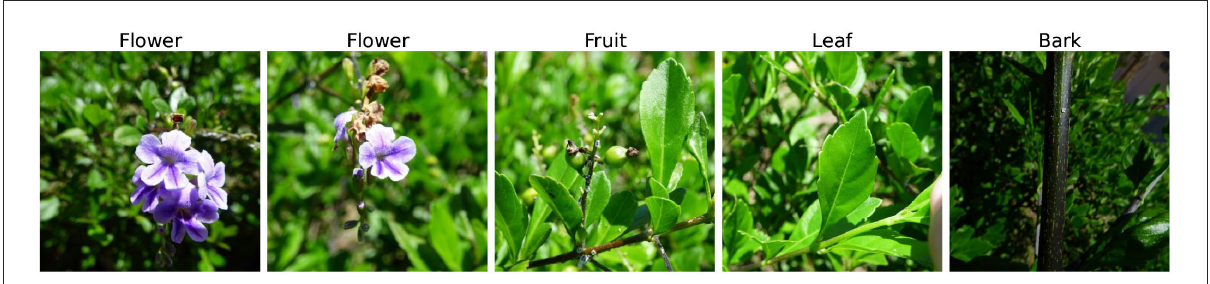
FIGURE2 A PlantCLEF observation—images of different plant parts. Images by Hugo